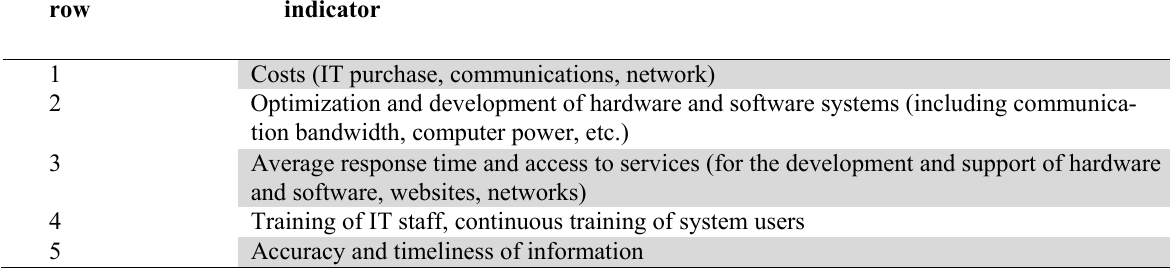
Selected indicators of information technology in the supply chain of oil products